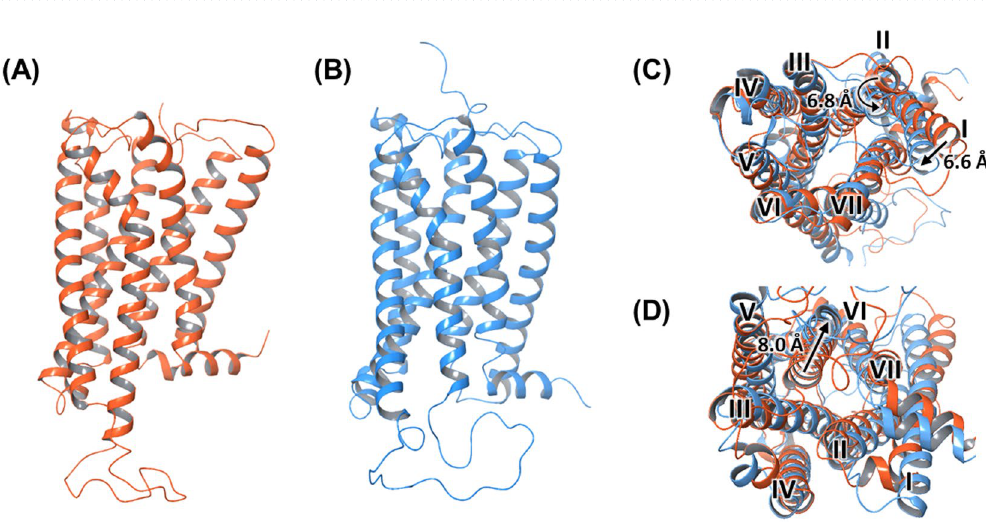
Figure 2. ( A ) Inactive conformation ( B ) active conformation, and the structural comparison of ( C ) extracellular and ( D ) intracellular part of two CB1 structures. To clarify the structural changes of two conformations of CB1, seven helices are labeled as